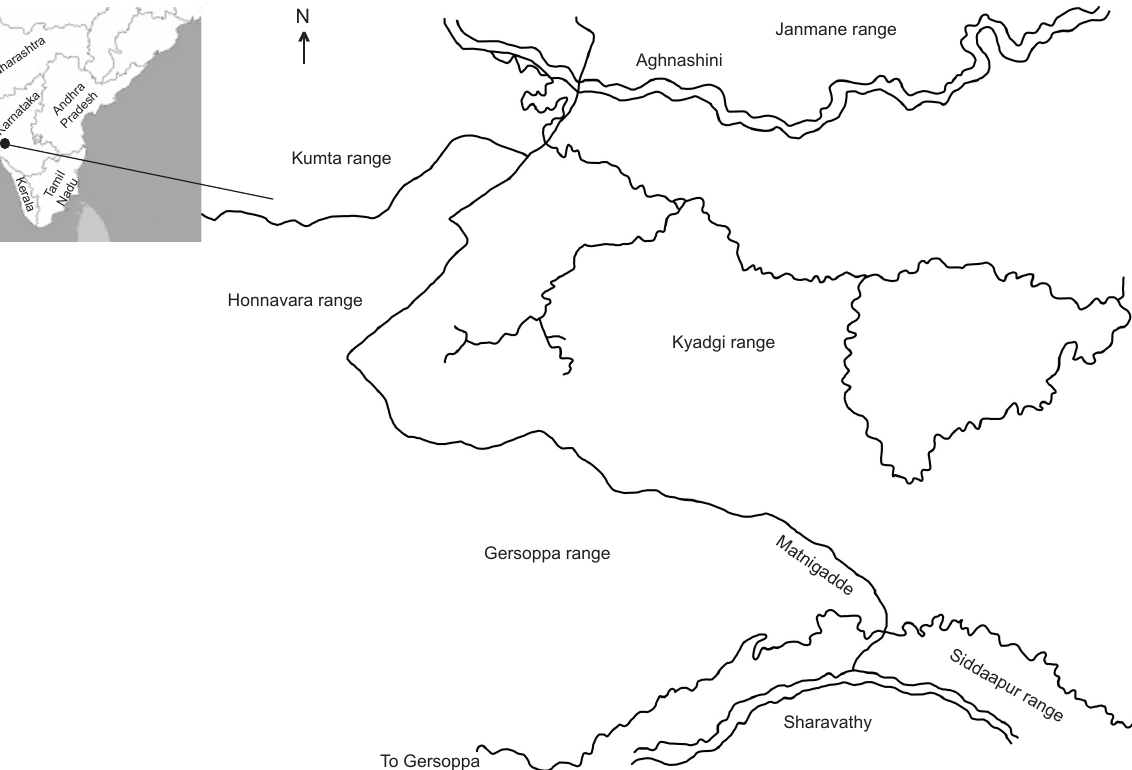
Figure 1. Map of the study area. Aghnashini and Sharavathy are the major rivers and other place names indicate forest